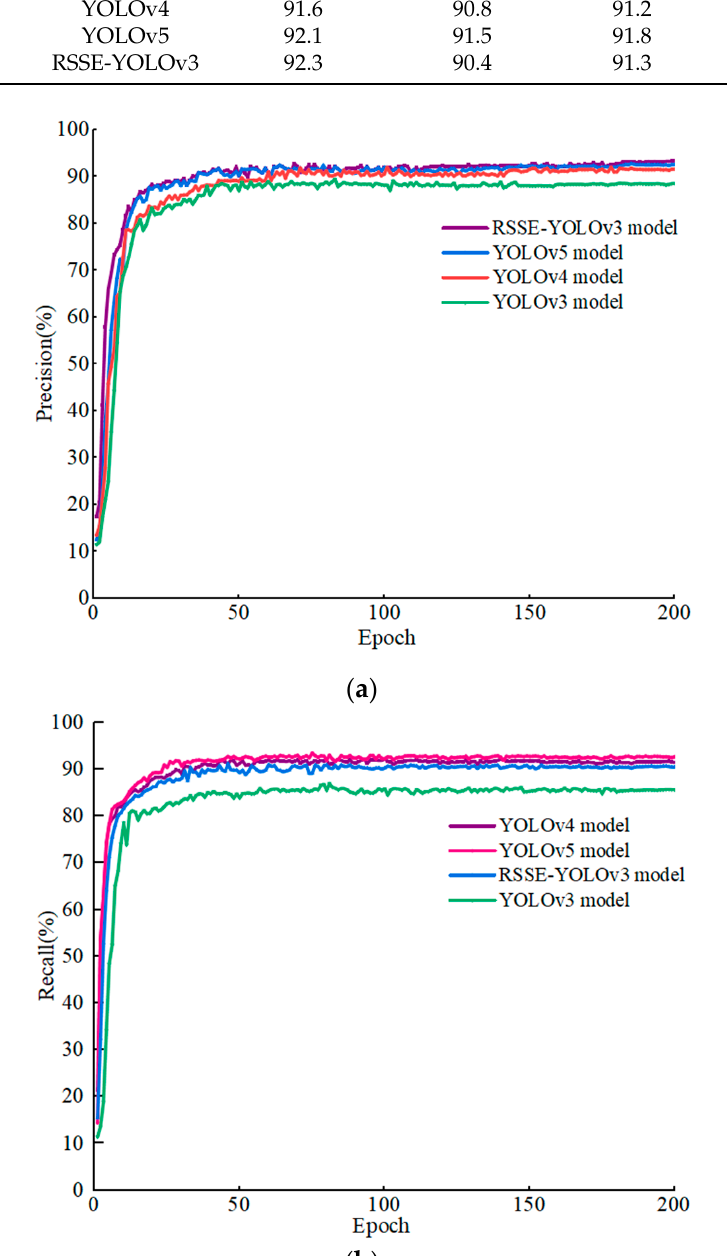
Figure 7. The curves of precision and recall in the different algorithms. ( a ) The curves of precision; ( b ) The curves of recall.